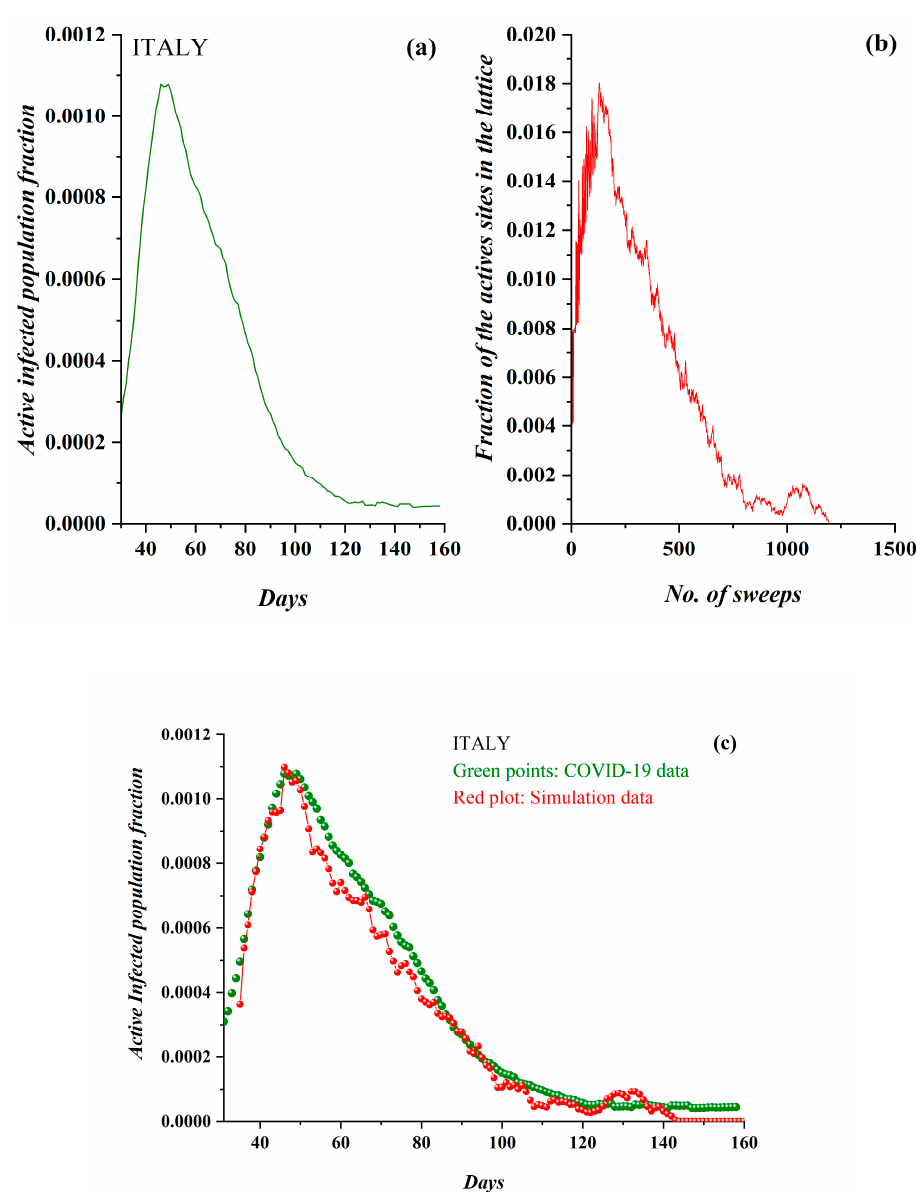
Figure 8. ( a ) The fraction of the active COVID-19-infected population daily in Italy (from 1 March 2020). ( b ) The fraction of active lattice sites in the SODM simulation vs. the number of lattice sweeps, is shown. ( c ) The epidemiological data for Italy in green points, fitted by the SODM simulation data, in red points. Note that each day corresponds to 11 sweeps.